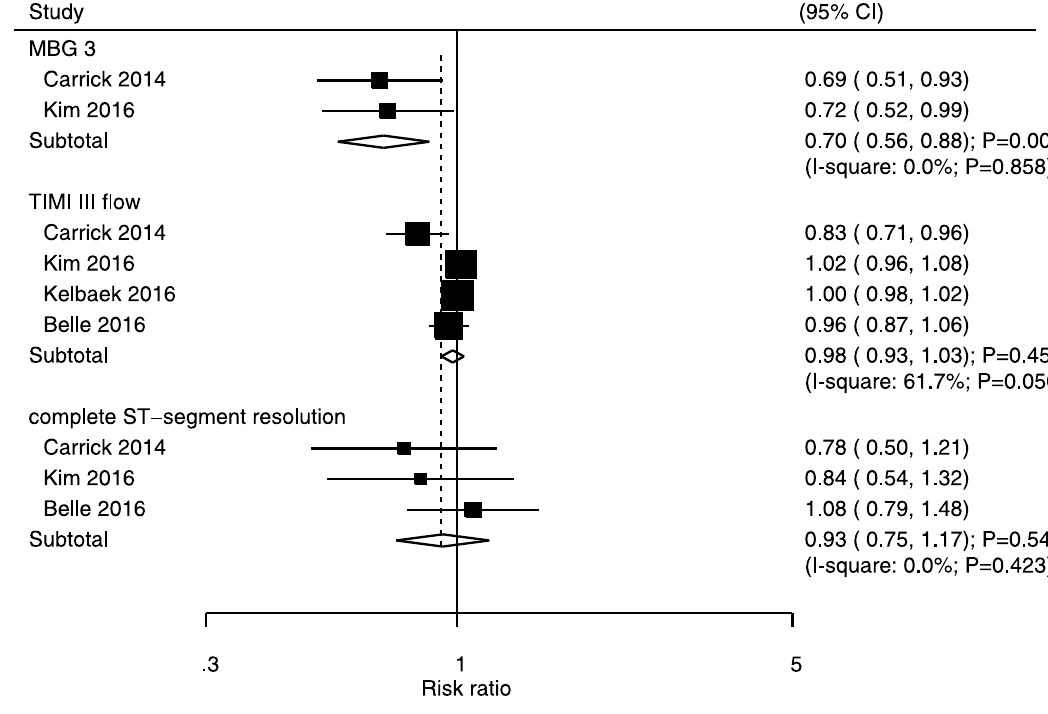
PLOS ONE | https://doi.org/10.1371/journal.pone.0234655 July 2,